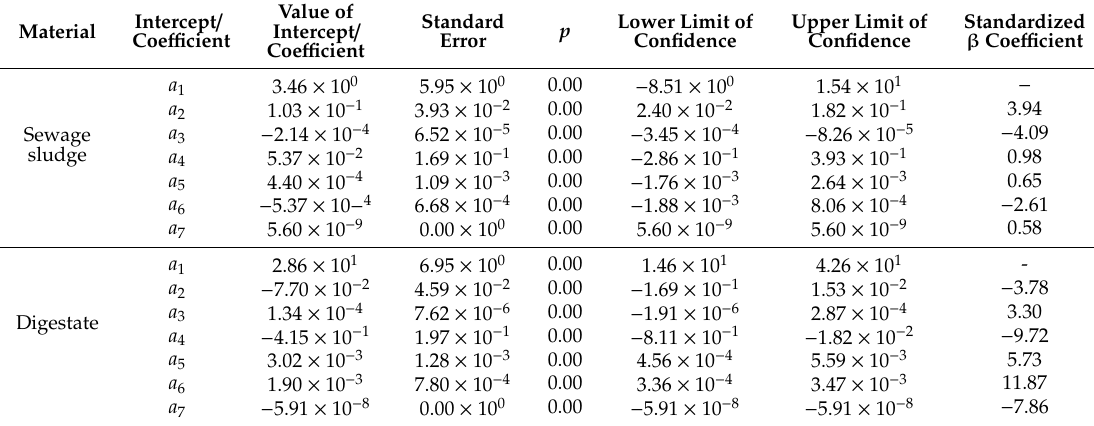
Table A7. Statistical evaluation of model coe ffi cients for the HHV of CSF from sewage sludge and